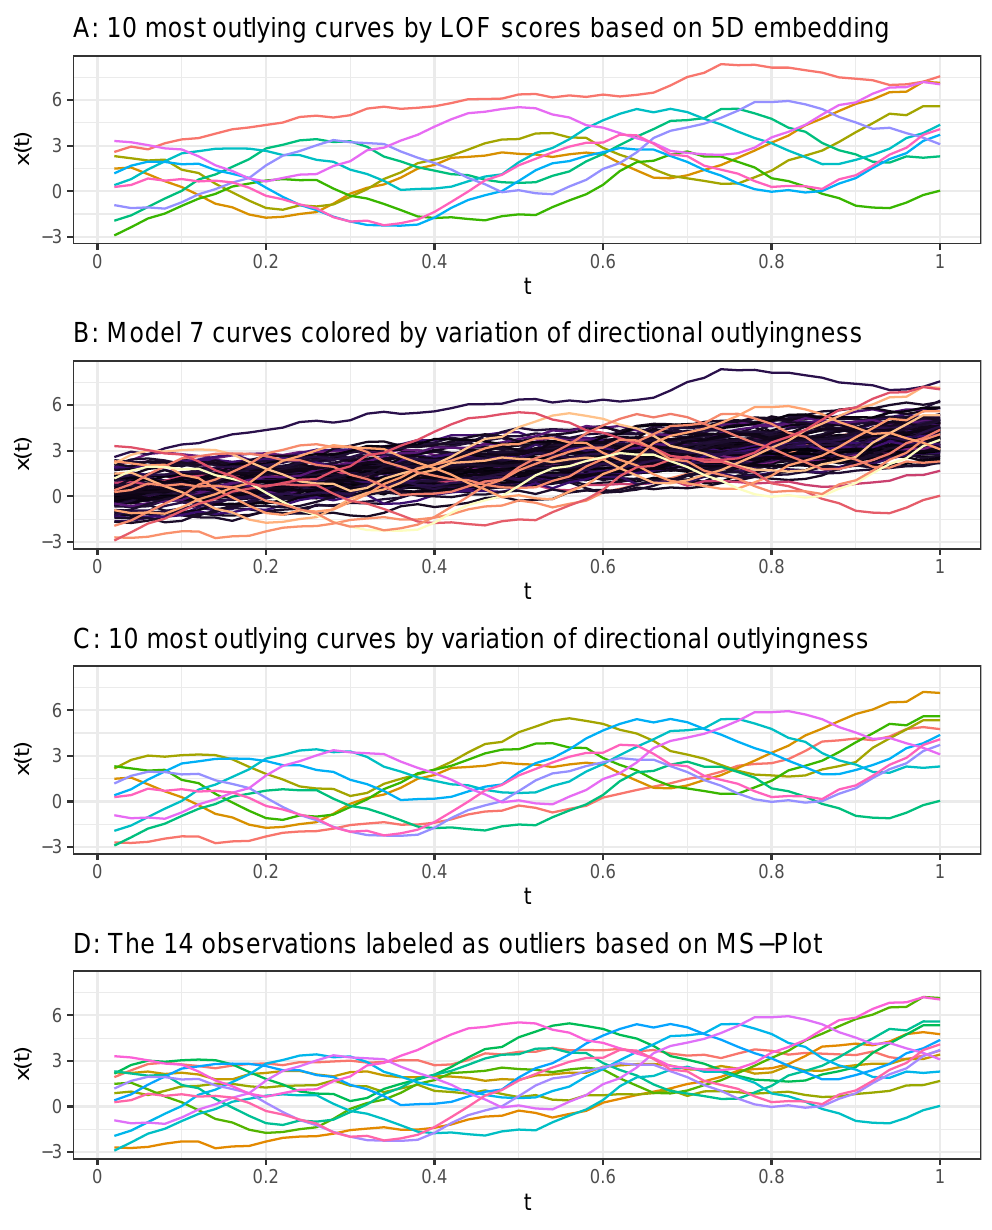
Figure A15. Model 7 data: the LOF on MDS embeddings in contrast to directional